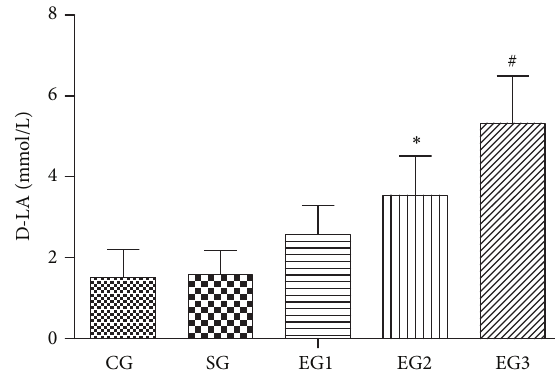
Figure 1: The level of D-lactate in each group. CG = control group; SG = sham group; EG1 = exposure group with peritoneal air exposure for 1h; EG2 = exposure group with peritoneal air exposure for 2 h; EG3 = exposure group with peritoneal air exposure for 3 h. Values are expressed as mean ± SD. ∗ 𝑃 = 0.001 , # 𝑃 = 0.000 , compared with CG.